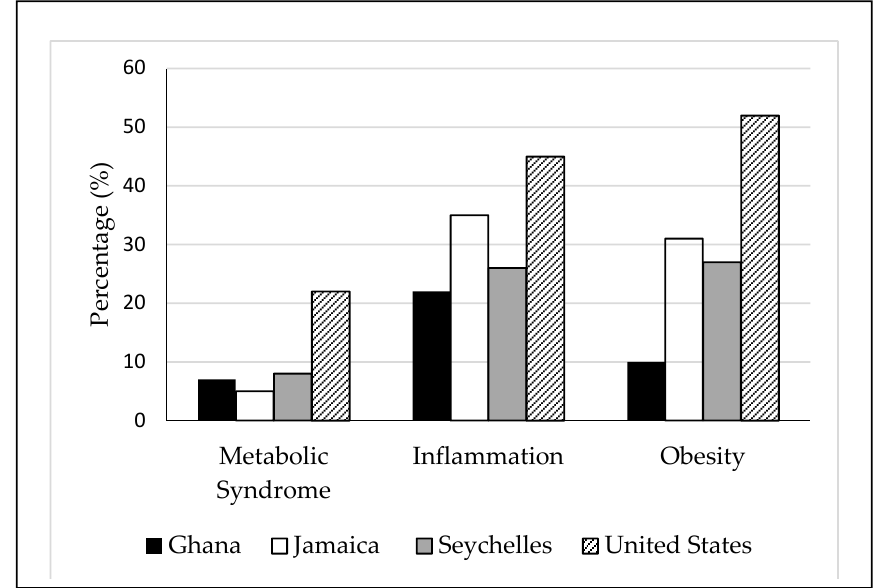
Figure 1. Comparison of prevalence of cardiometabolic risk by site. Metabolic syndrome was defined according to the Adult Treatment Panel III criteria [38,39] where individuals had at least three cardiometabolic components. Inflammation was defined as C-reactive protein concentrations >3.0 mg/L [40,41]. Individuals with a body mass index ≥ 30 kg/m 2 were defined as obese [42].